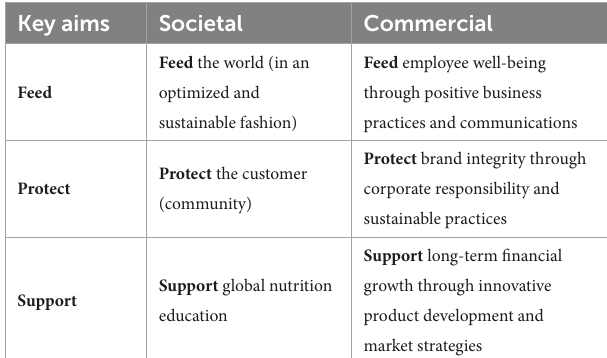
TABLE 2 Benefits of the Metabolic Matrix from a societal and commercial